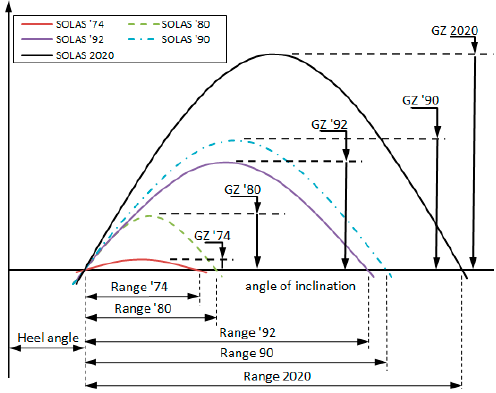
Figure 1. Damage stability evolutionary changes (initial diagram from [51] with SOLAS 2020 added for comparison purposes); see also [37,44].